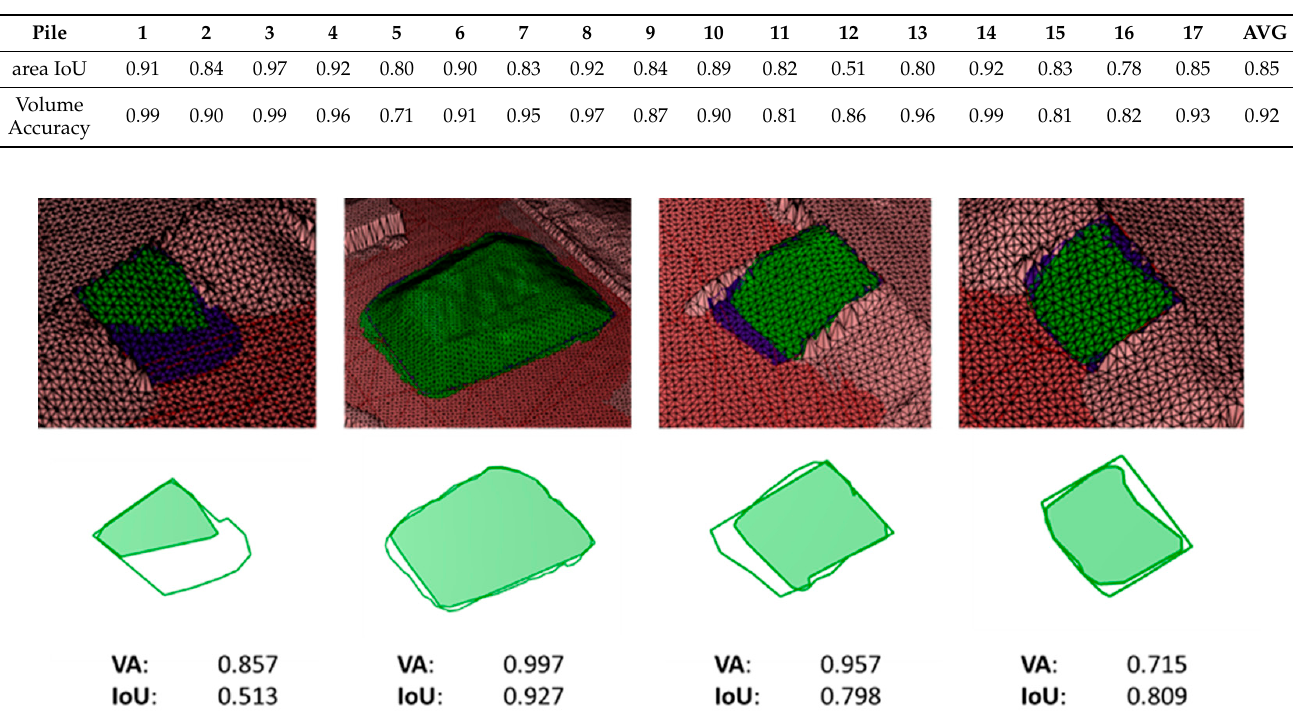
Table 2. IoU-scores regarding the footprint-areas and volumetric accuracy regarding the true and the predicted volume. The table shows the results for 17 true-positive predictions from test site A as well as the average results across all 17 piles.